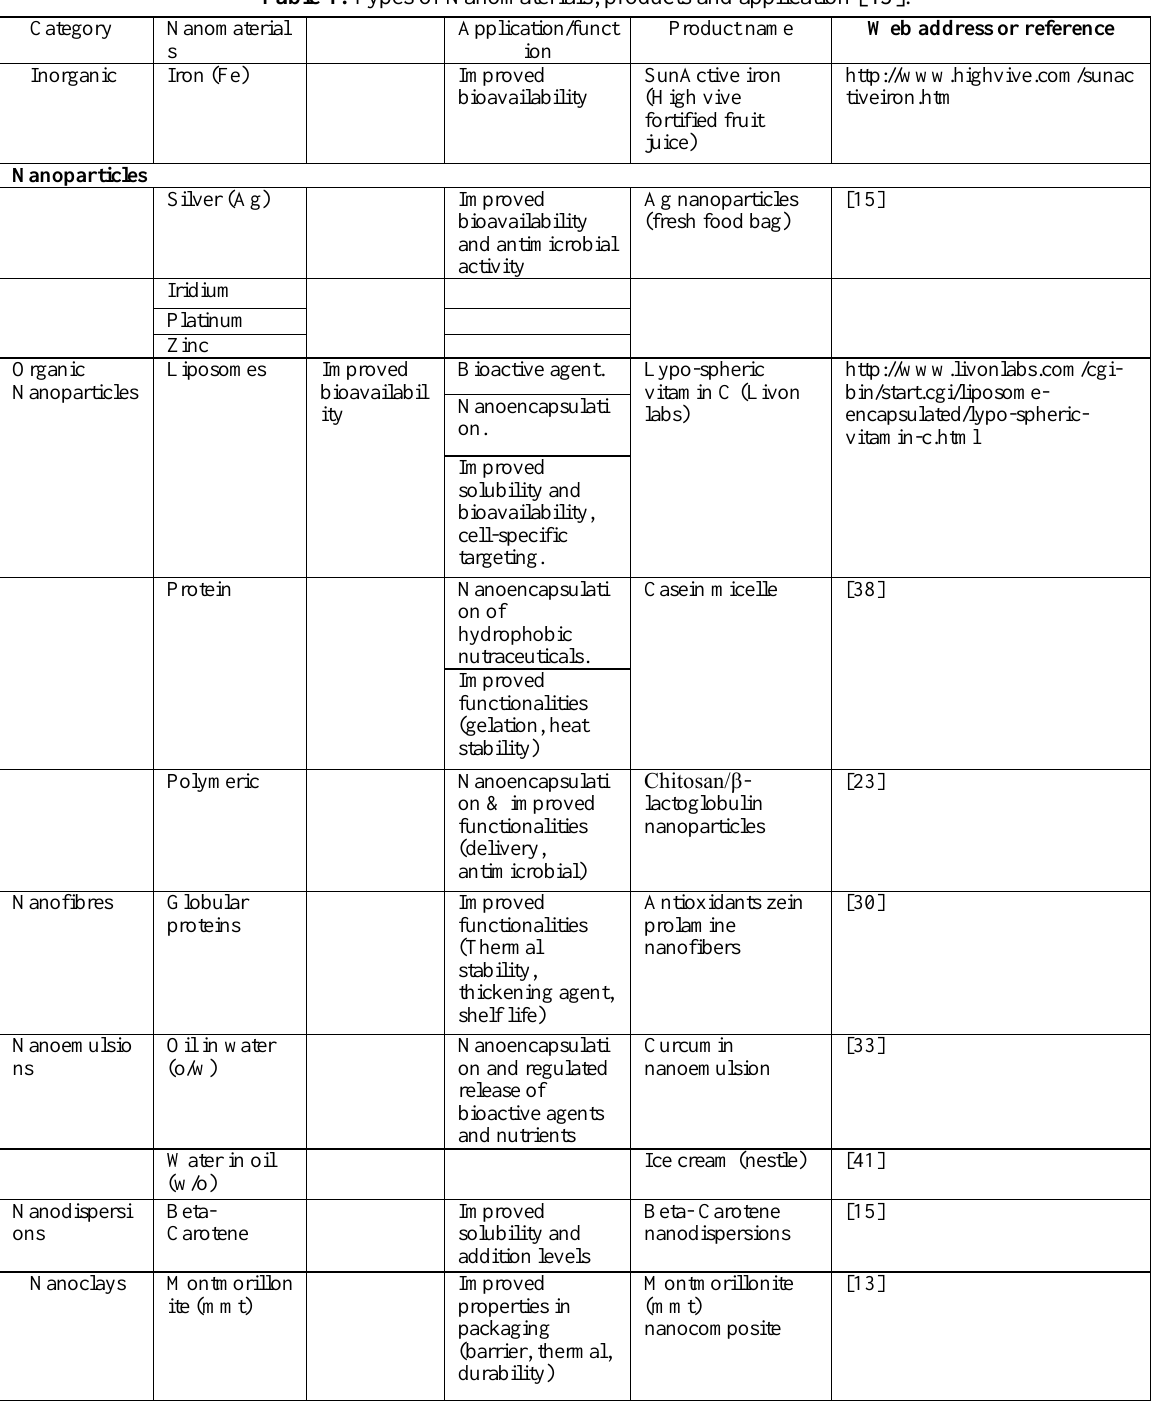
Table 1. Types of Nanomaterials, products and application [43]